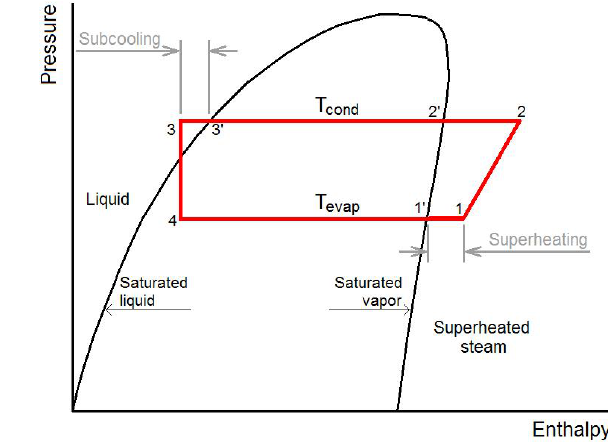
Figure 4: Pressure-enthalpy diagram of a